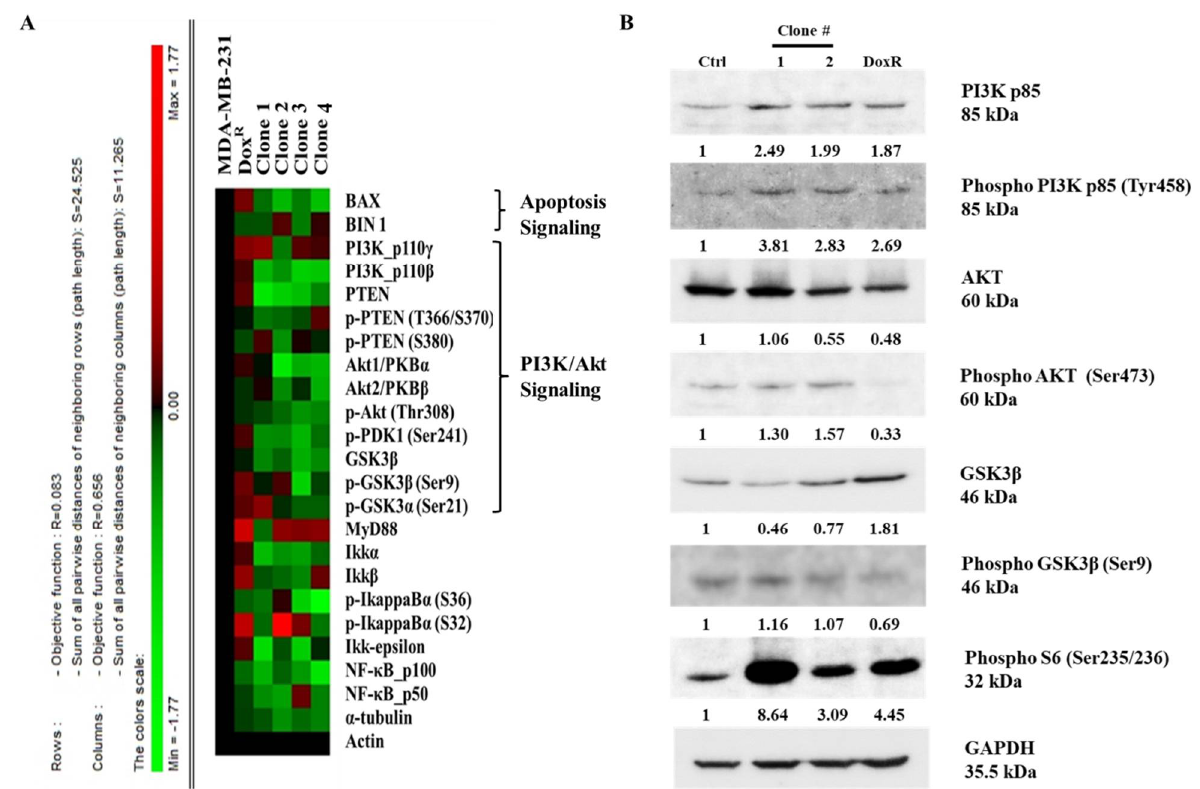
Figure 8. Representative results of the microwestern array and western blotting. ( A ) Target proteins of different signaling pathways, such as apoptosis, PI3K/Akt, and NFκB, were evaluated in control/parental MDA-MB-231, DoxR, and DEHP- exposed clones #1, 2, 3, and 4. Downregulation of PTEN, GSK3β, and BAX was observed in DEHP-exposed clones. The expression levels of different genes are represented by different colors from the control. Green represents downregulation with a minimum score of -1.17, and red represents upregulation with a maximum score of +1.17. ( B ) Representative western blot results show activation of PI3K/Akt signaling in DEHP exposed MDA-MB-231 cells. Upregulation of PI3K p85, Phospho-PI3K p85 (Tyr458), Phospho-AKT (Ser473), Phospho-GSK3β (Ser9), and Phospho-S6 (Ser235/236) was observed along with slight downregulation of AKT in clone #2 and downregulation of GSK3β in DEHP exposed clone #1 and #2.